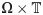
Illustration of the parts of input space used for training the PINN.(a) forward model and (b) inverse model. The collocation (Ω×T), boundary and initial points (∂ΩD×T and Ω at t = 0) are utilized in the forward model. However, only the training points (Ω×T) are employed in the inverse model. X represents a set of spatial coordinates (x, y, and z), t is a set of coordinates in the time domain, and S is a set of solution values (u and p) corresponding to X and t.